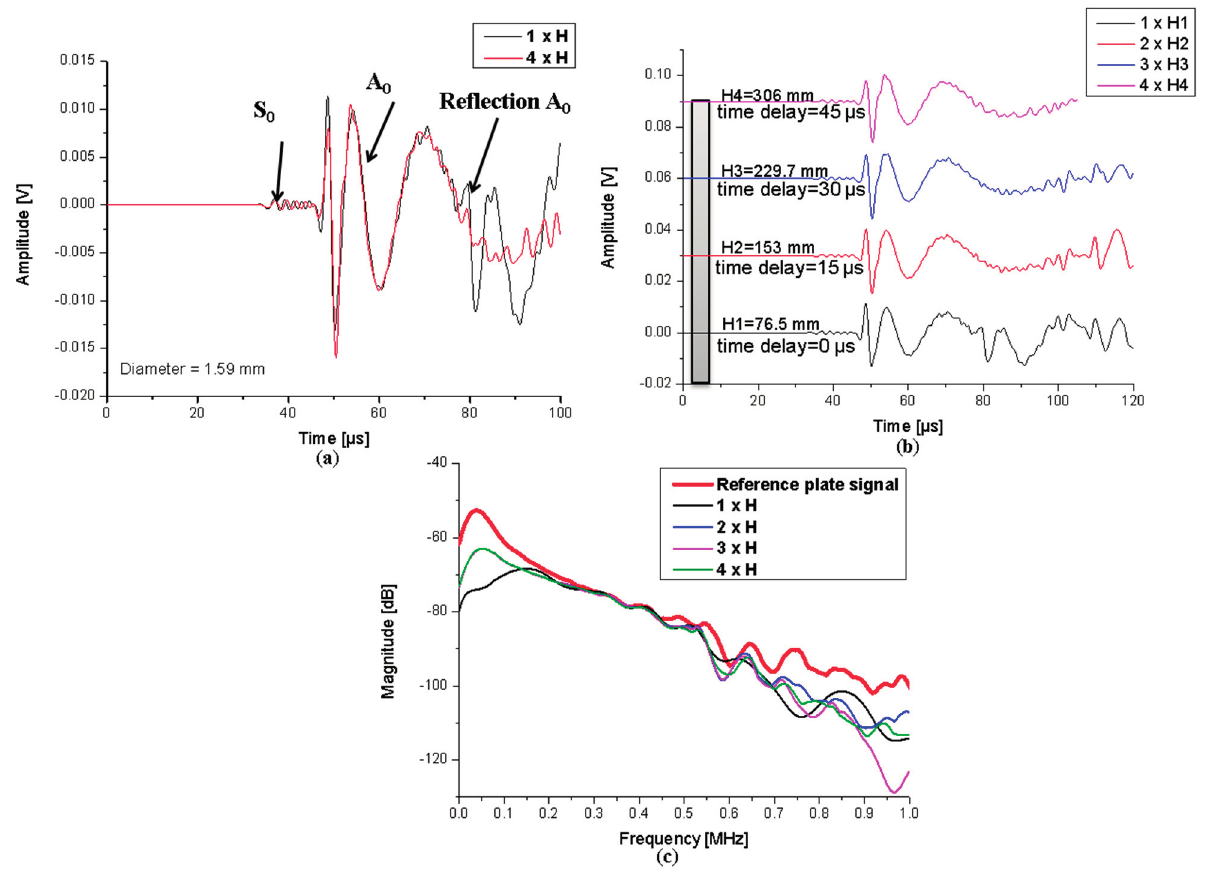
Figure 13. Calculated signals for ( a ) extreme WG length cases; ( b ) all cases and ( c ) frequency spectra